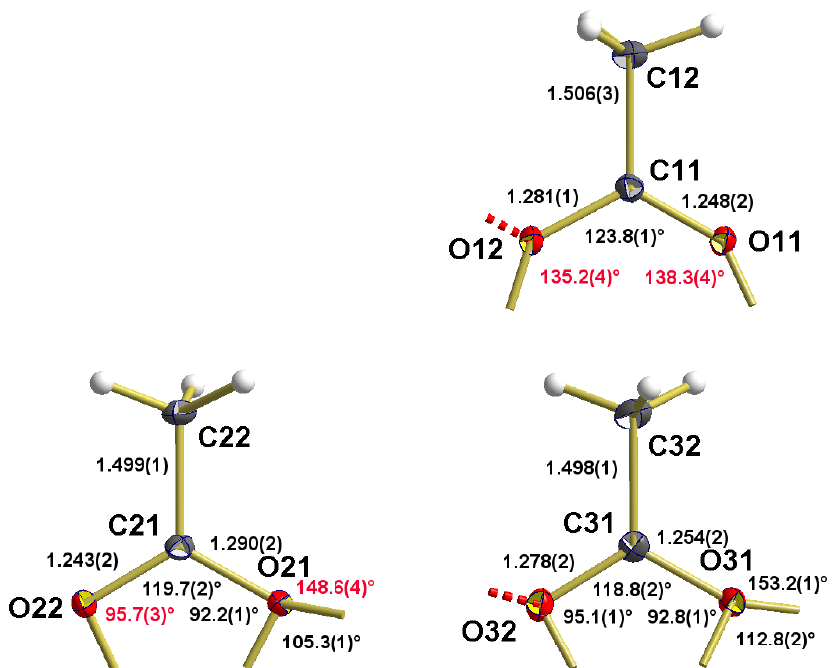
Figure 6. Coordination modes of the acetate groups in the RE(OAc) 3 · 2AcOH structure type; example RE = Nd. C-C and C-O bond lengths [Å] arithmetically averaged over all 4 compounds, standard deviations of averaging in brackets. Bonds from oxygen to RE are indicated by short sticks, hydrogen bonds by short, dashed sticks in red. Mean values correlating with RE marked in red.